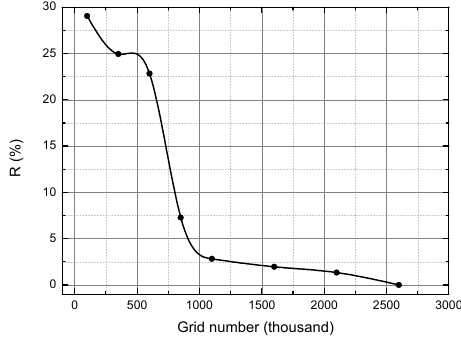
Figure 3. Dimensionless temperature difference ratio curve.